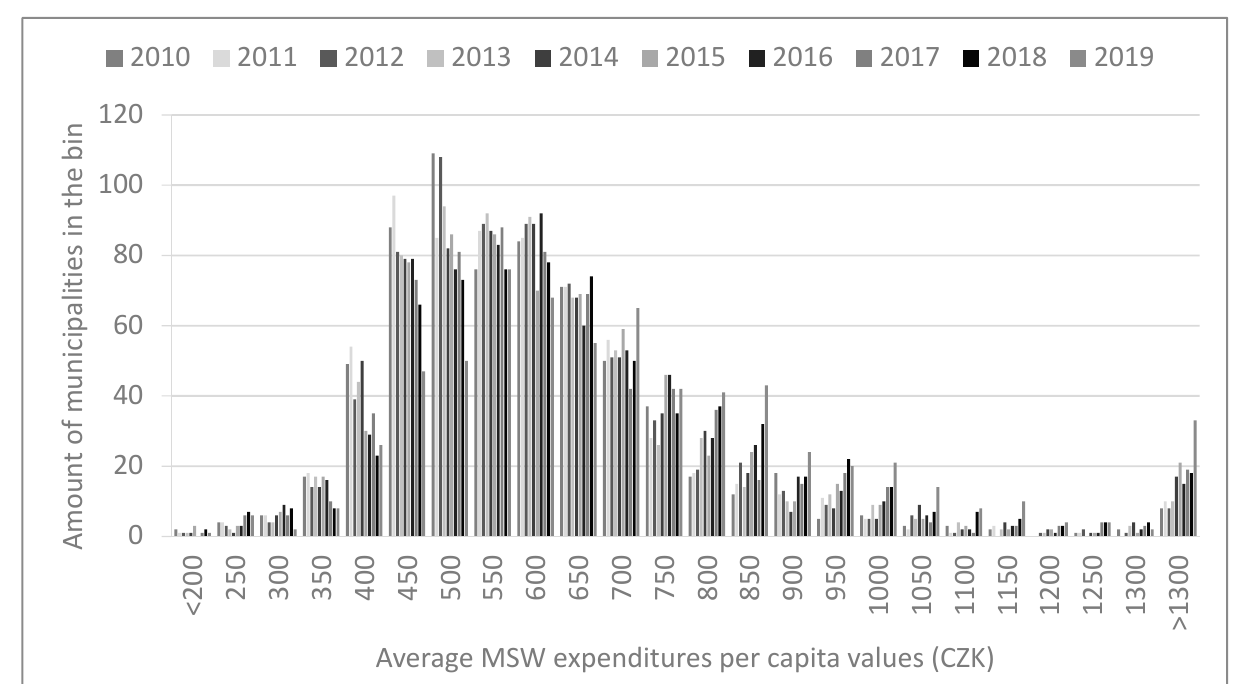
Figure 1. Histogram of average municipal solid waste expenditures per capita in the analyzed group of municipalities, 664 units. Municipalities with reported values over 1300 are grouped in the category >1300.